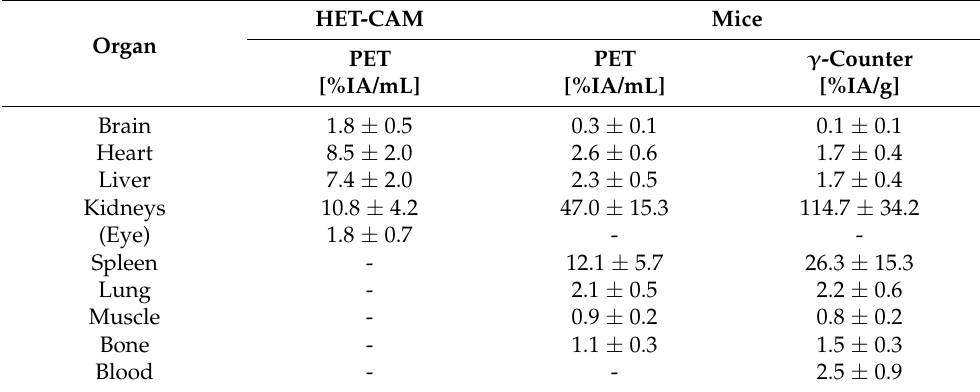
Table 2. Summary of the mean activity concentrations in the organs of interest obtained with γ -counter and PET measurement for both in vivo